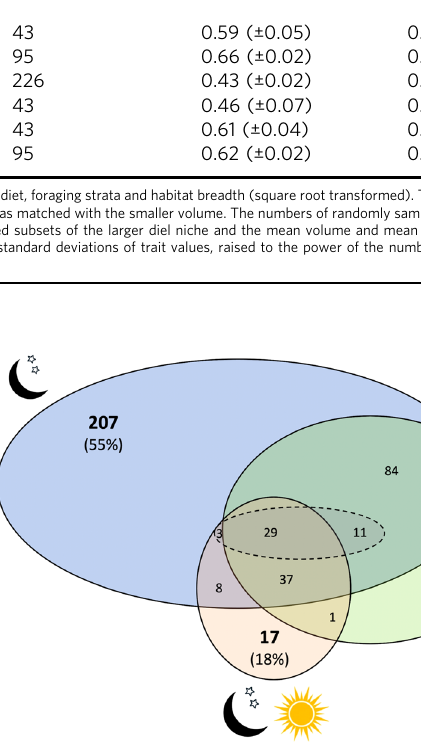
Fig. 2 Two-dimensional representation of the overlap in fi ve-dimensional trait space of species occupying different diel niches. Nocturnal species are shown in blue (full volume 375 SD 5 , moon and stars silhouette), crepuscular species by the dash oval (full volume 43 SD 5 ), cathemeral species in peach (full volume 95 SD 5 , moon, stars and sun image) and diurnal species in green (full volume 226 SD 5 , sun image). Hypervolumes for each diel niche were constructed on the basis of fi ve z-transformed traits: body mass (log 10 ), litter size (log 10 ), diet, foraging strata and habitat breadth (square root transformed). Comparative analyses on paired hypervolumes were carried out, where numbers in bold specify the unique volume for each diel niche and numbers not in bold give the overlapping volumes of diel niches. The percentage of the hypervolume that is unique to each diel niche is given in parentheses. Statistical approaches are not available for comparing more than two hypervolumes, and so overlapping volumes are estimated based on paired overlaps (See Supplementary Table 3 for paired hypervolume analyses with unmatched sample sizes). The units of the unique and overlapping fractions are SD 5 . Note that one crepuscular species had a unique combination of traits that was not possible to represent in the fi